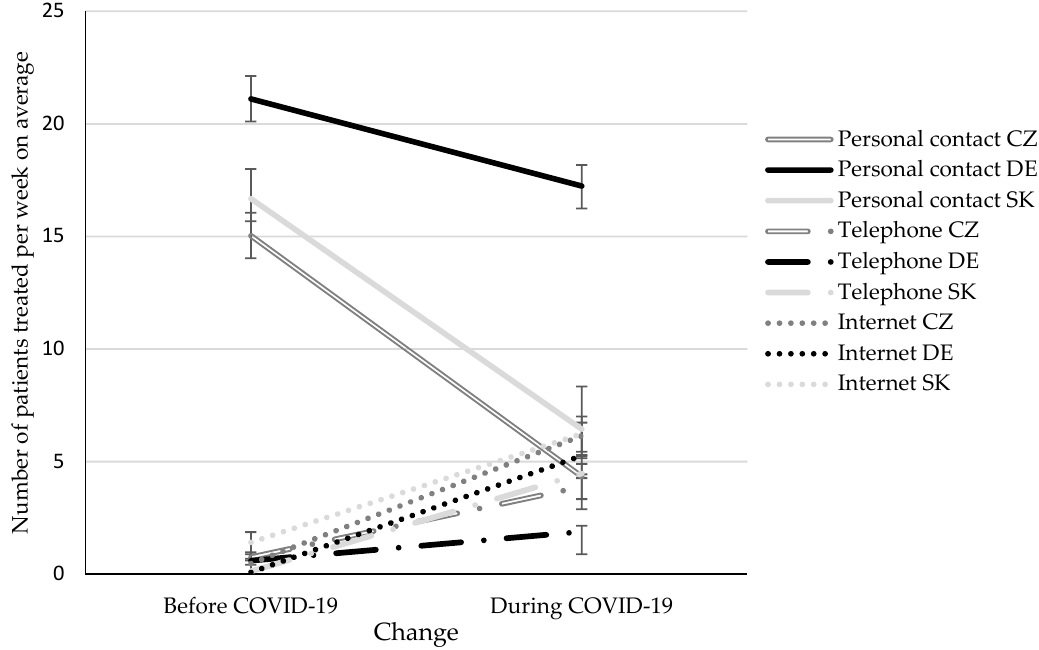
Figure 1. Average number of patients treated per week in personal contact, via telephone or via internet in the months before / during the COVID-19 situation in Czech (CZ), German (DE) and Slovak (SK) psychotherapists. Mean ± standard error.